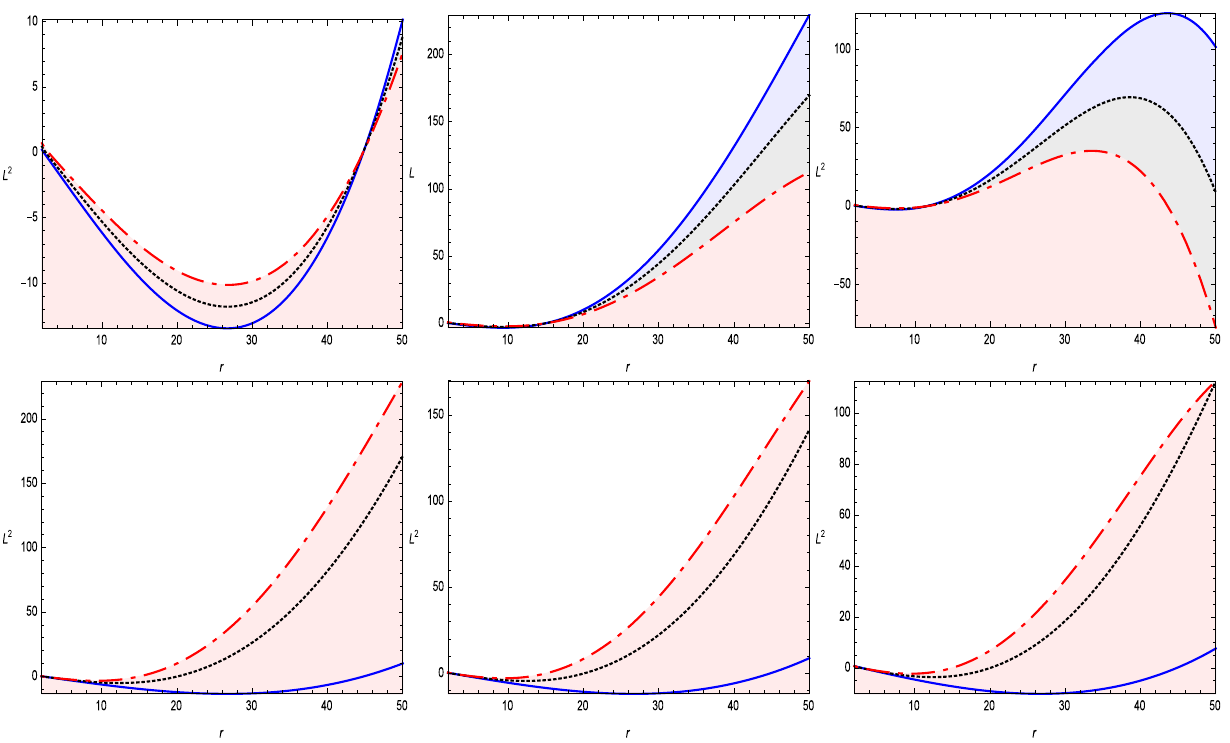
Fig. 9 Shows the behavior of L 2 for the different possible values of a and q . The left panel of the first row represents q = 0 . 01 (blue), q = 0 . 02 (black), and q = 0 . 03 (red) with a = 0 . 1. The middle panel of the first row represents q = 0 . 01 (blue), q = 0 . 02 (black), and q = 0 . 03 (red) with a = 0 . 2. The right panel of the first row represents q = 0 . 01 (blue), q = 0 . 02 (black), and q = 0 . 03 (red) with a = 0 . 3.